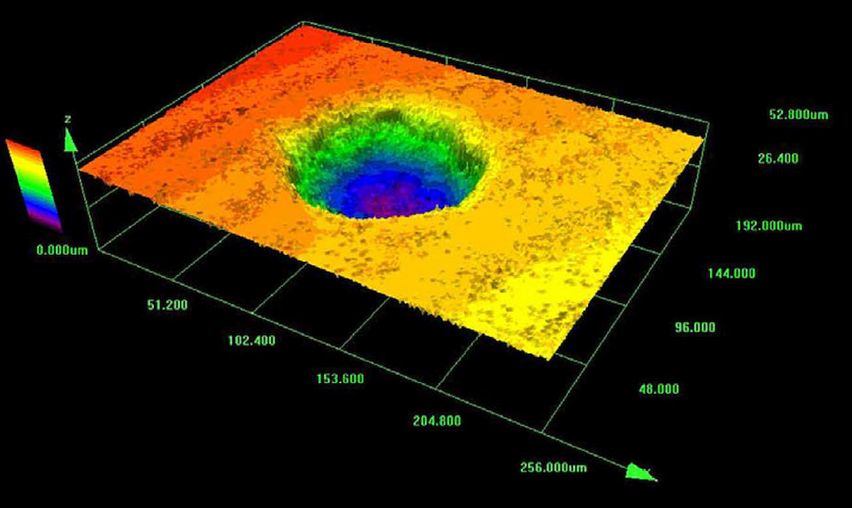
Figure 17. A confocal 3D relief of a single pore of hydrated Portland cement paste; 47 optical cuts with a vertical stepping of 1.2 μm. Olympus LEXT 1000, confocal mode, Olympus factory software. Taken from [27].